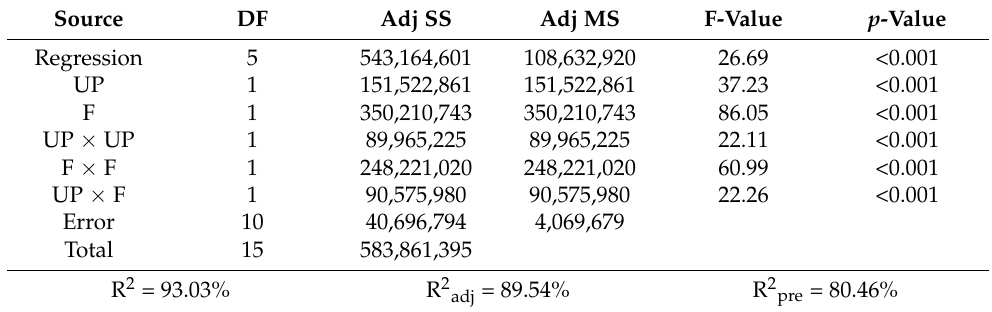
Table 5. Variance analysis of the pore